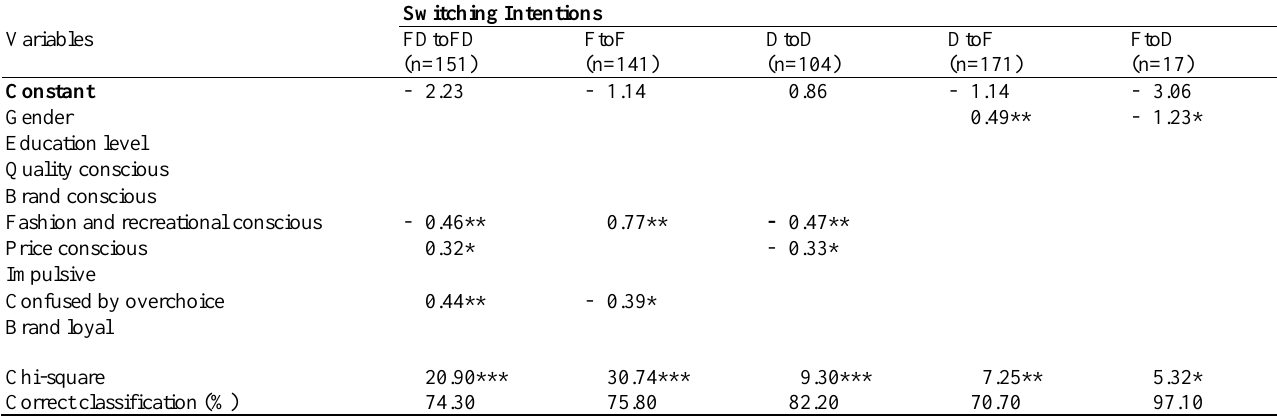
Table 5: Logistic regression results for decision-making styles by five sports shoes switching